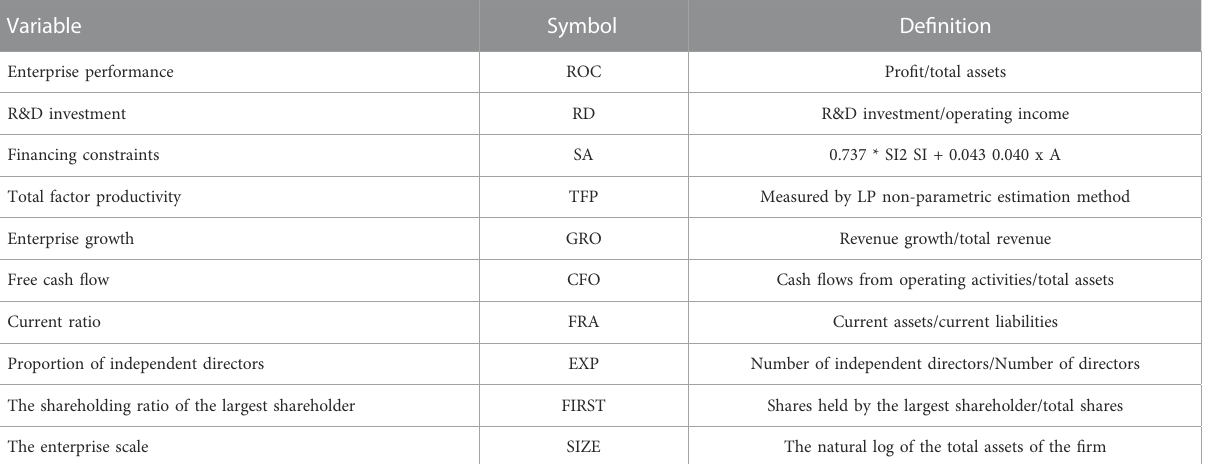
TABLE 1 Variable de fi nitions.